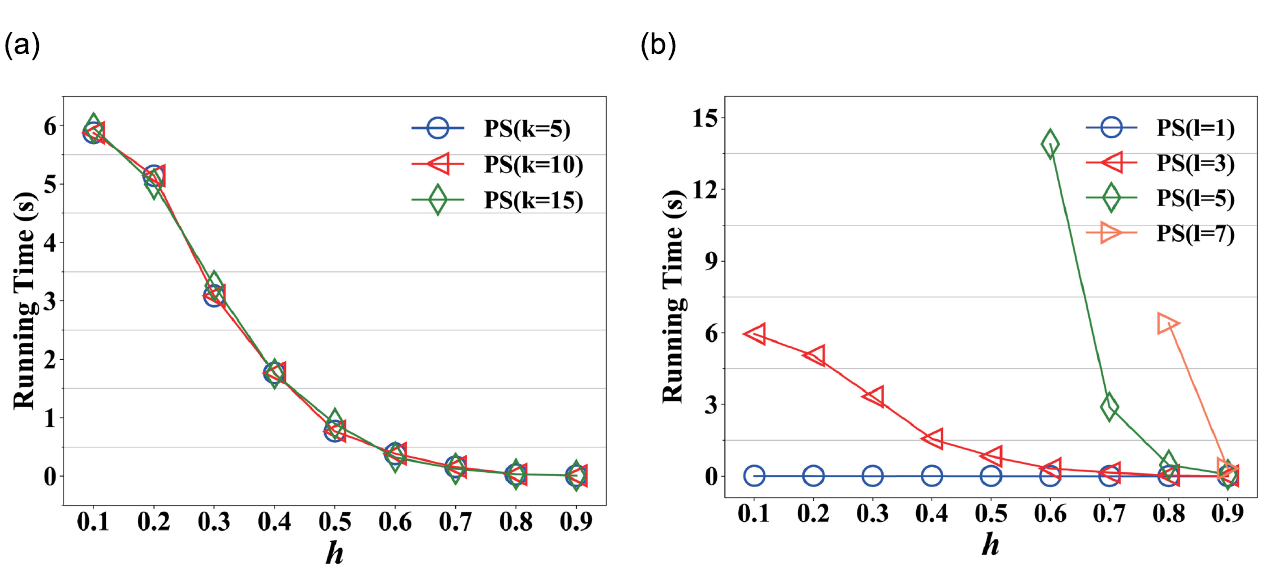
Fig 5. Running time on varying h in Nipic. (a) Running time on varying h at l = 3, (b) Running time on varying h at k = 10.